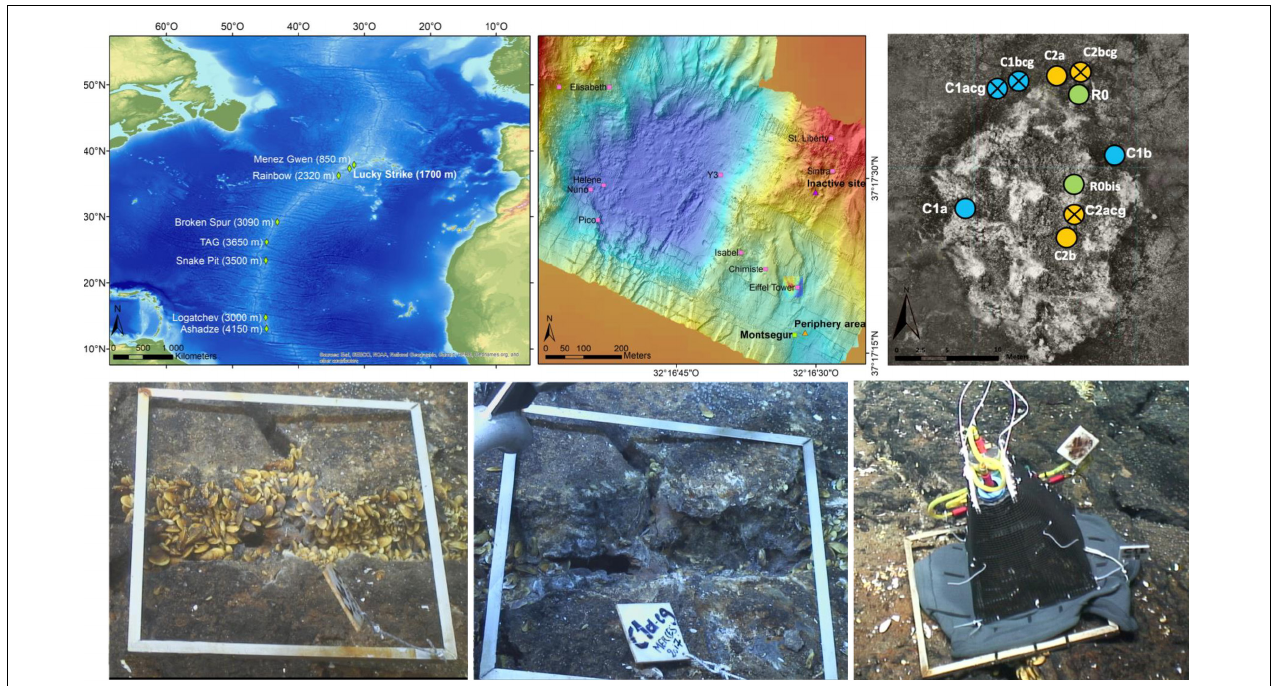
FIGURE 1 | (Top left) Location of the Lucky Strike vent field on the Mid-Atlantic Ridge, south of the Azores. (Top center) The 1 km 2 Lucky Strike vent field with the Montségur edifice on the south-east. (Top right) View of the full in situ experiment on the Montségur hydrothermal edifice. (Bottom left) Experimental quadrat C1a_cg at the base of Montségur and Bathymodiolus assemblage, prior to clearance. (Bottom center) Experimental quadrat C1a_cg after clearance; the suction device (metal pipe) is shown at the top left corner of this panel. (Bottom right) Experimental quadrat that has been covered by pyramidal cage and a skirt in 2018. All quadrats measure 50 × 50 cm in